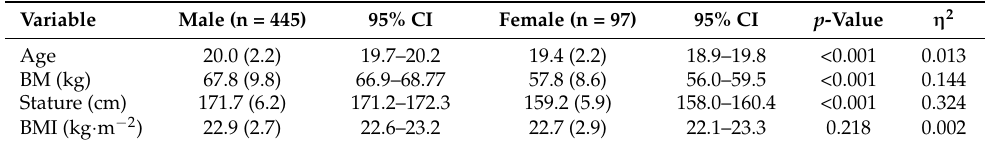
Table 1. Characteristics of the